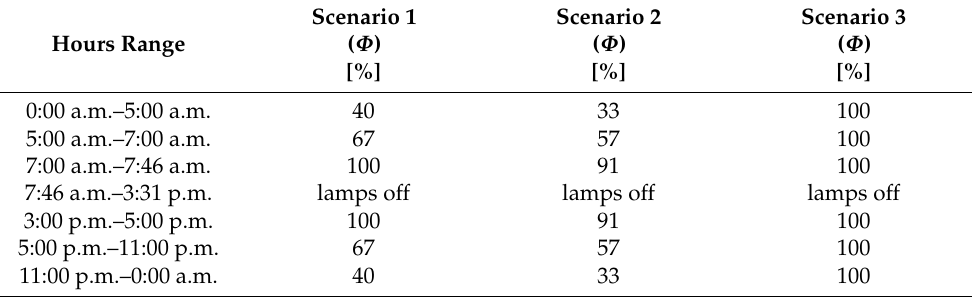
Figure 15. Lighting scenario number 3 (no lighting control)—the installation works with full luminous flux over the whole range of operation, providing road luminance values compliant with M4 class for the whole operating time of the lighting installation. Table 9. Required levels of luminous flux emitted by lighting installations in order to ensure the required levels of road luminance on January 1st 2020 (for given lighting scenario).